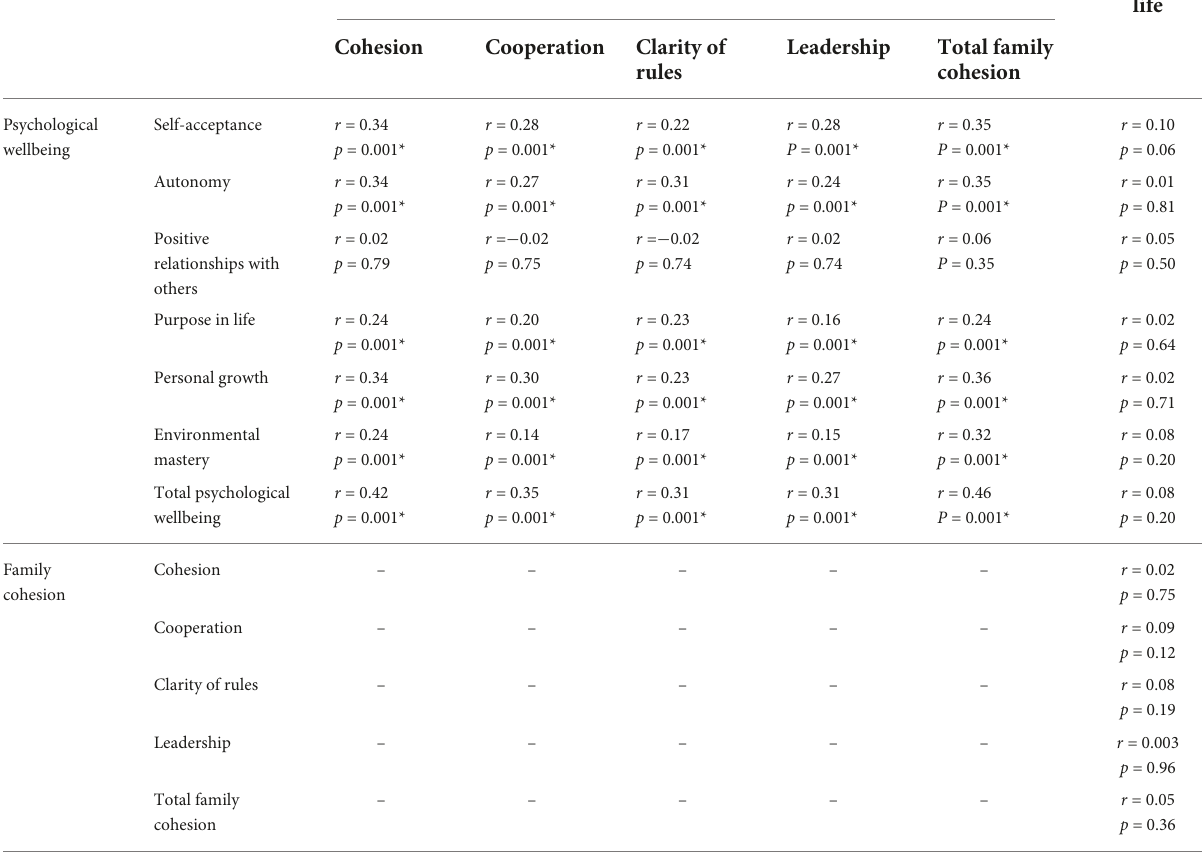
TABLE 3 Correlation between the measured variables.